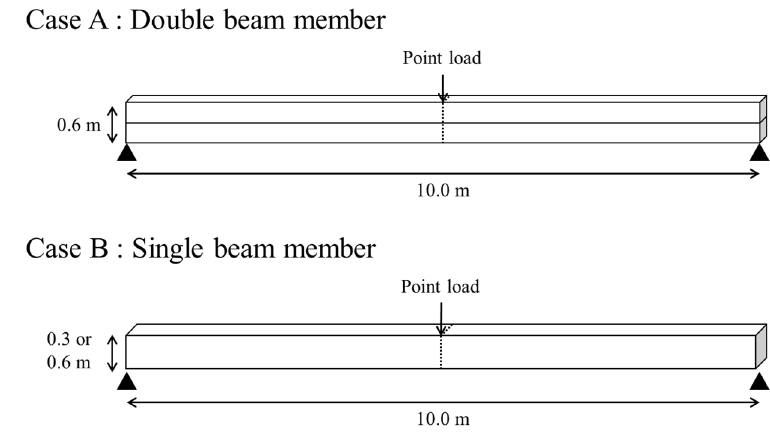
Figure 10. Analysis of the contact behavior of general beam members.